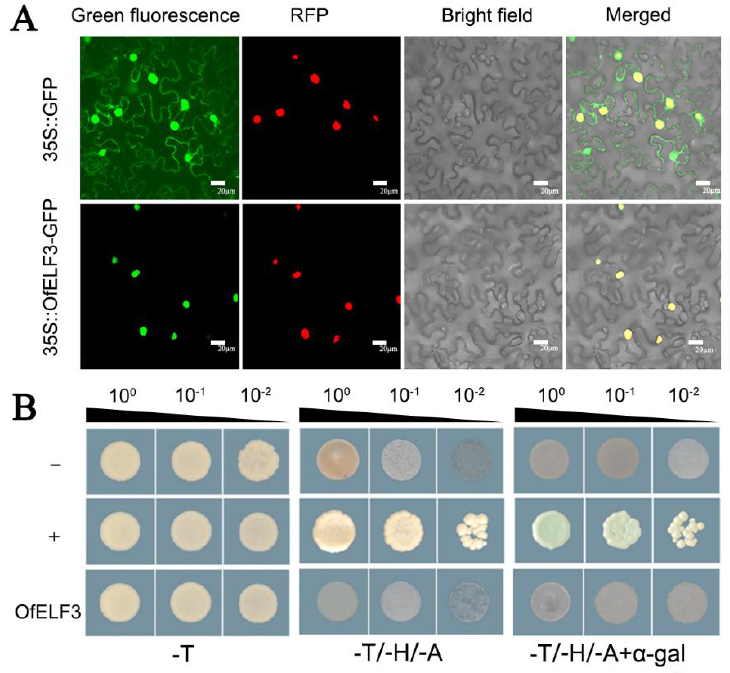
Figure 2. Subcellular localization and transcriptional activity assay. ( A ) Subcellular localization analysis in N. benthamiana leaves. 35S::GFP is the control, and 35S::D53-RFP is a nuclear marker. Scale bars = 20 µm. ( B ) OfELF3 protein transcriptional activity assay in yeast. – , negative control; +, positive control.